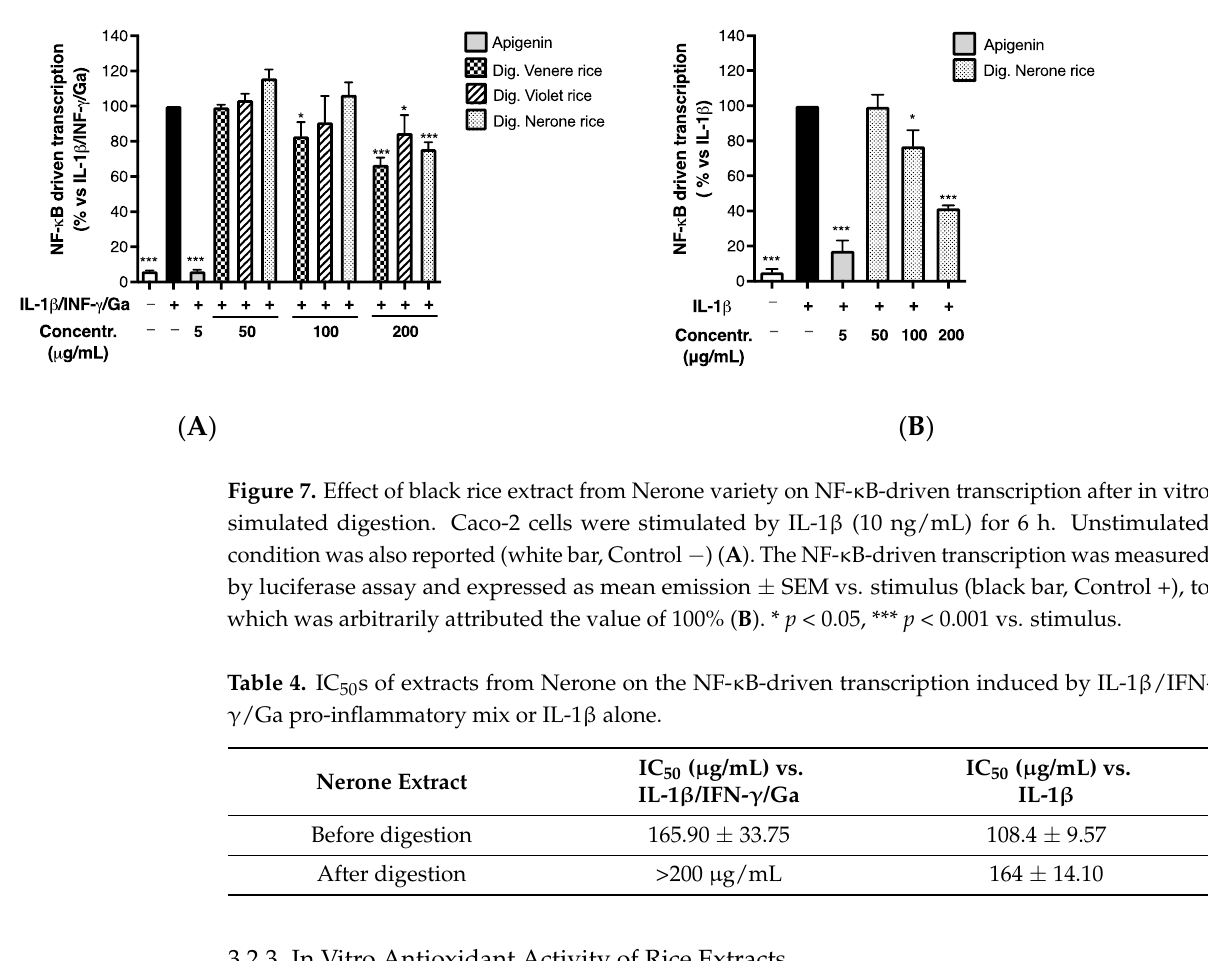
Figure 6. Effect of black rice extracts on IL-8 ( A ), sICAM-1 ( B ), and CXCL-10 release ( C ) after in vitro simulated digestion. Caco-2 cells were stimulated by IL- 1β (10 ng/mL), IFN - γ (10 ng/mL), and in vitro digested gliadin (Ga) (1 mg/mL) for 6 h. Unstimulated condition was also reported (white bar,